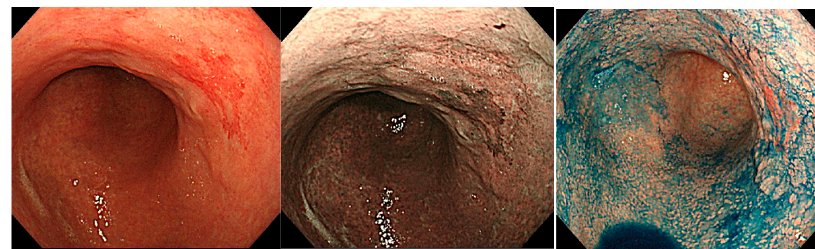
Figure 8. Images of gastric cancer with AIG.